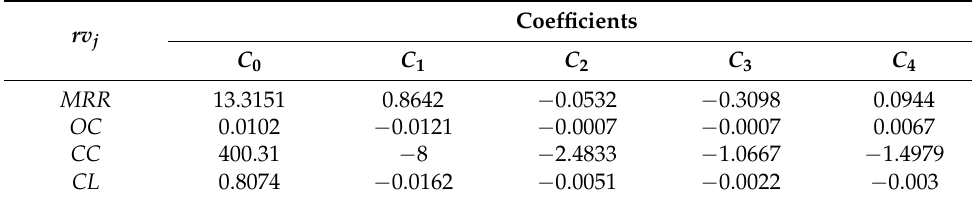
Table 3. Coefficients of linear regression equations—annealed.